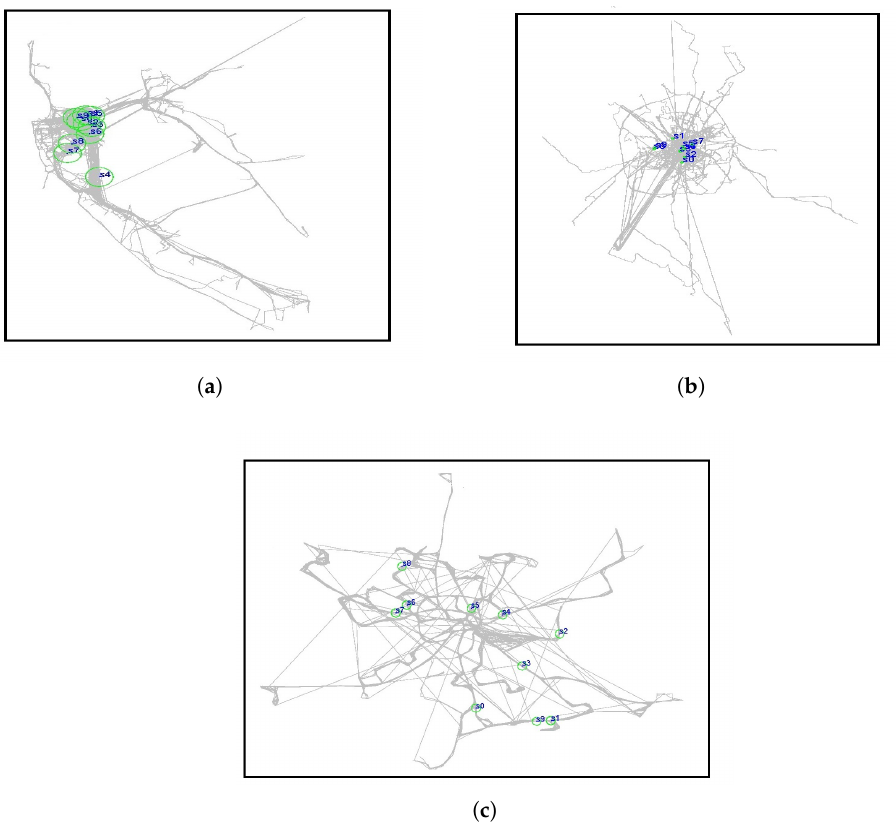
Figure 1. The structure of the city of ( a ) San Francisco ( b ) Rome ( c )